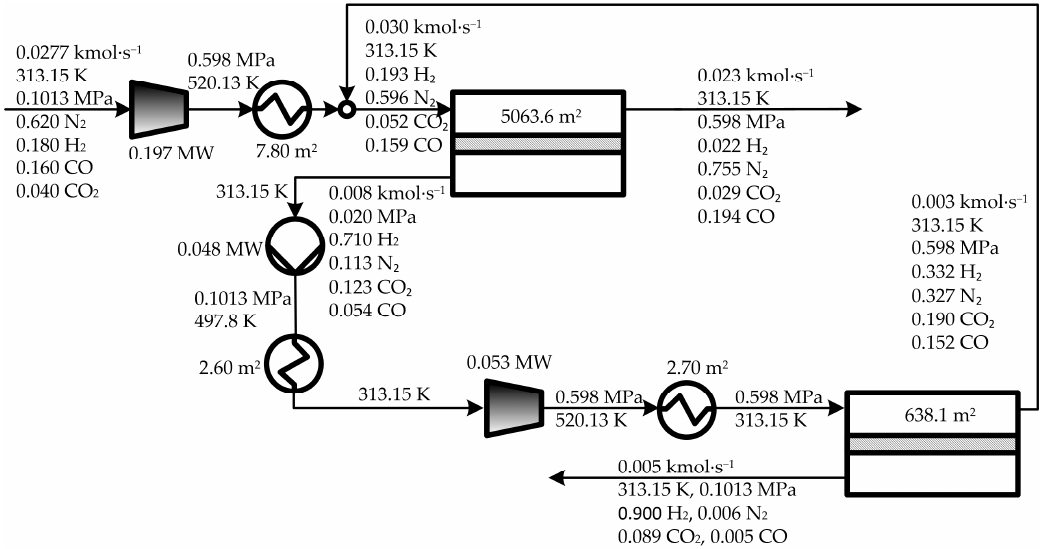
Figure 3. Optimal process configuration obtained in solution (OPT), in which the driving force is created by combining compression and vacuum and no expander is included.